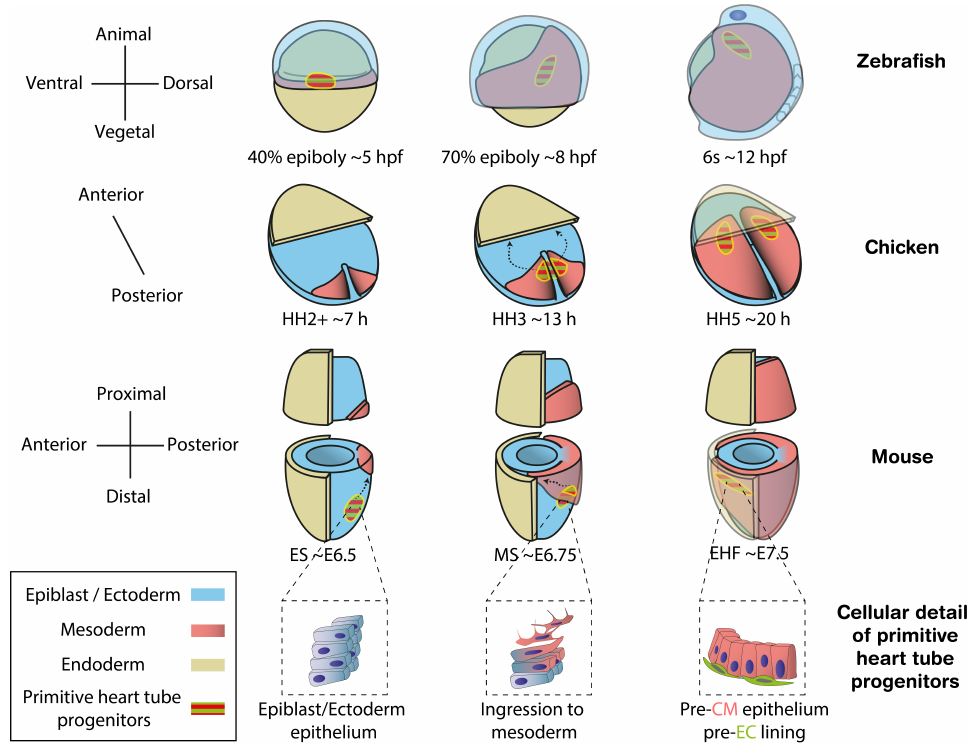
Figure 1. Location of cardiac progenitors in vertebrate models from the onset of gastrulation to the stage preceding primitive heart tube formation. Cardiac progenitors ingress the mesoderm soon after the start of gastrulation, migrating to the opposite side of the embryo to establish the two layers that form the primitive heart tube. The different rows of diagrams show this process in mouse, chicken, zebrafish and a zoom-in for the cellular detail of primitive heart tube progenitors, respectively. Zebrafish diagrams are depicted from dorsal views while those in chick and mouse show ventral views. Morphological staging follows the epiboly rate, Hamburger–Hamilton (HH) and Downs [14] criteria for zebrafish, chicken and mouse, respectively. Approximate time in hours post fertilization (hpf), hours (h) or embryonic day (E) are also provided. CM, cardiomyocytes; EC, endocardium. Dashed arrows depict the migration trajectory of primitive heart tube progenitors during